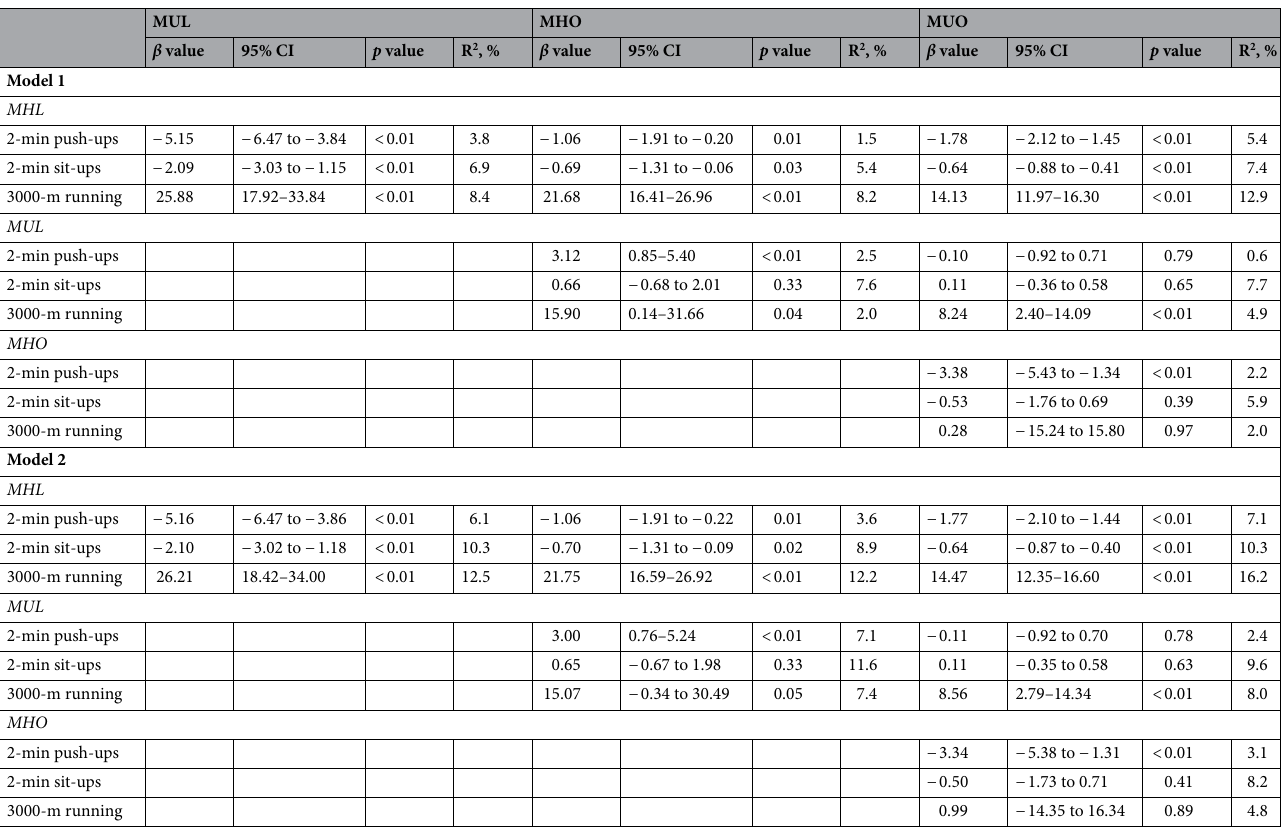
Table 3. Liner regressions of MUL, MHO and MUO with each exercise performance. Data are presented as β and 95% CI (confidence intervals) using Pearson’s correlation coefficients for Model 1: age and service specialty adjustments; Model 2: the covariates in Model 1, physical activity, current alcohol drinking and current smoking adjustments. MHL, metabolically healthy lean, defined as body mass index < 27.5 kg/m 2 and absence of two major components of the metabolic syndrome, according to the International Diabetes Federation criteria for Asian male adults; MHO, metabolically healthy obesity defined as body mass index ≥ 27.5 kg/m 2 and absence of two major components of the metabolic syndrome; MUL, metabolically unhealthy lean defined as body mass index < 27.5 kg/m 2 and presence of at least two major components of the metabolic